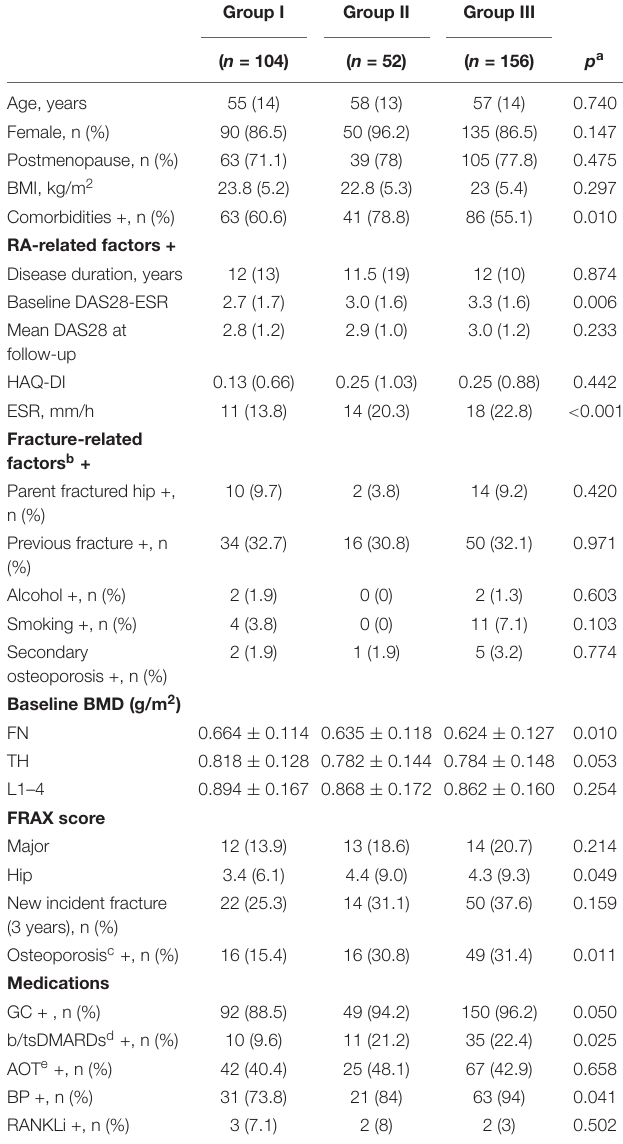
TABLE 2 | Clinical characteristics of participants grouped by presence of antibodies after matching.